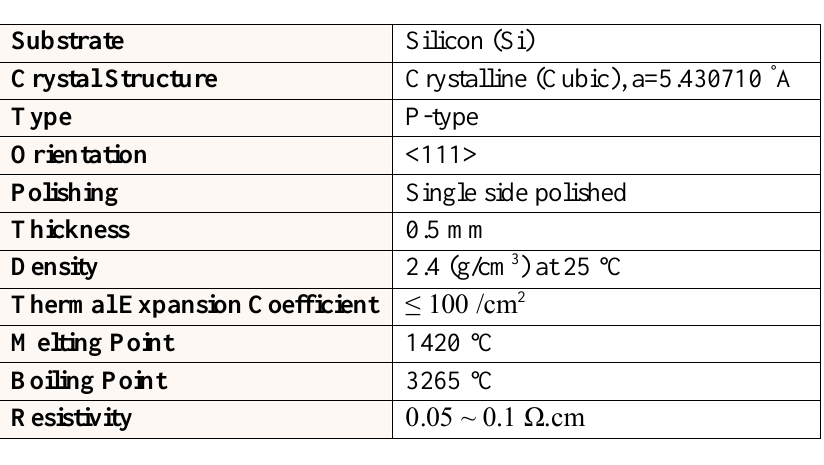
Table 2: Distinctive Properties of